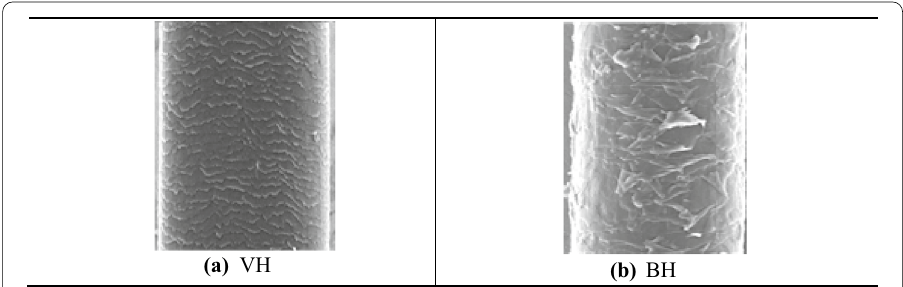
Fig. 2 SEM images of virgin hair (VH) and bleached hair (BH)